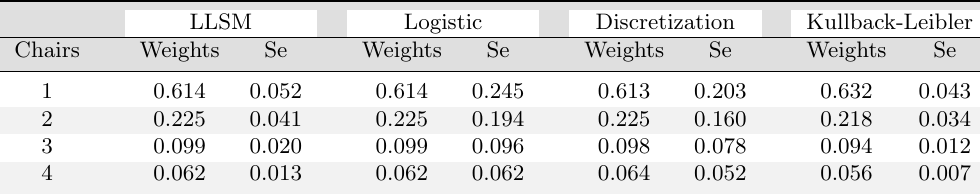
Table 1: Estimates of the weights and associated standard errors for chair brightness. It is clear that the distribution-based methods give practically the same weights, while the Kullback-Leibler distance approach gives slightly different weights, but that the ranking of chairs with respect to brightness is the same for all the four methods. It is also